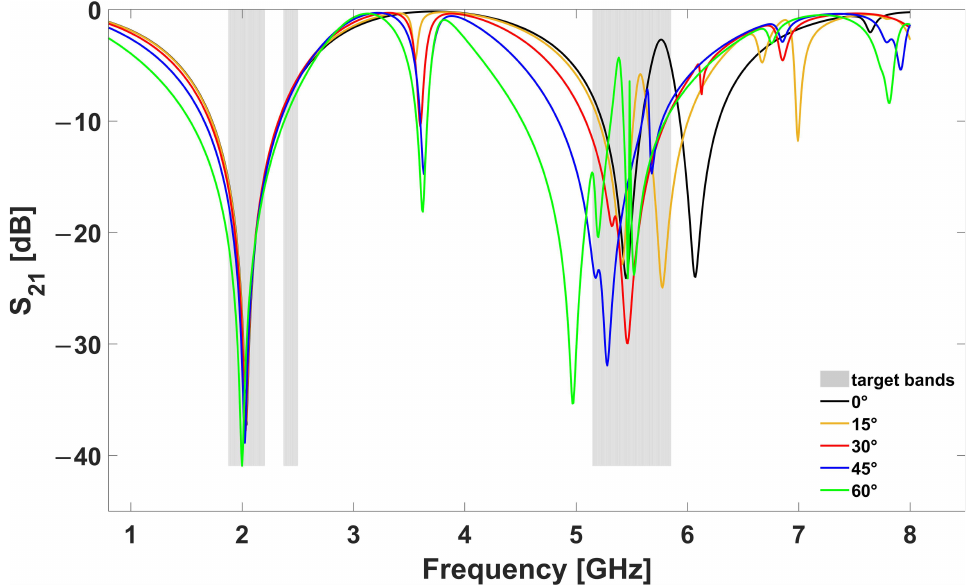
Figure 6. Simulated effect of increasing the inclination angle theta ( θ ) from 0 ◦ to 60 ◦